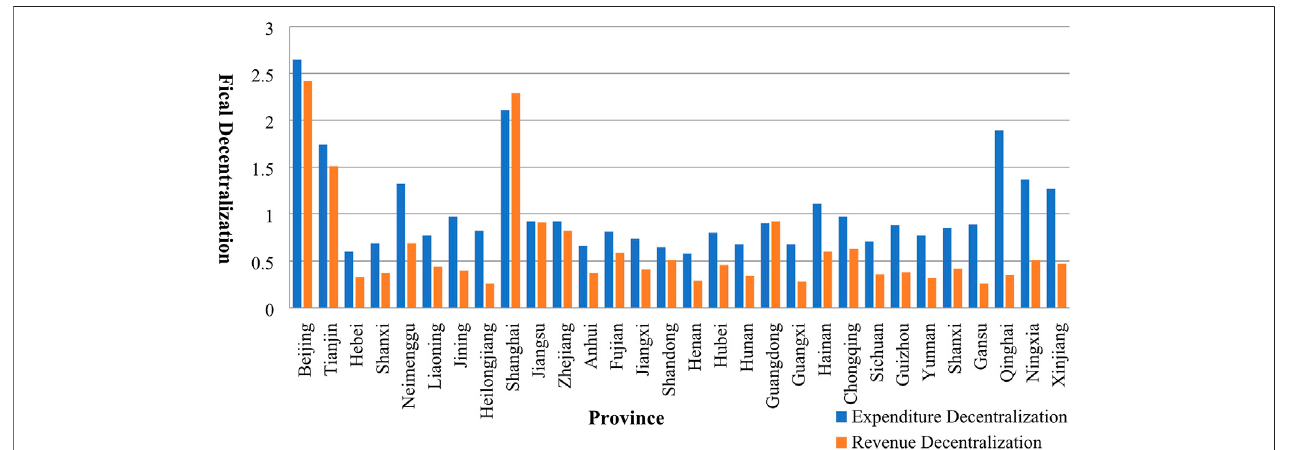
FIGURE 2 | The decentralization degree of expenditures and revenue in each